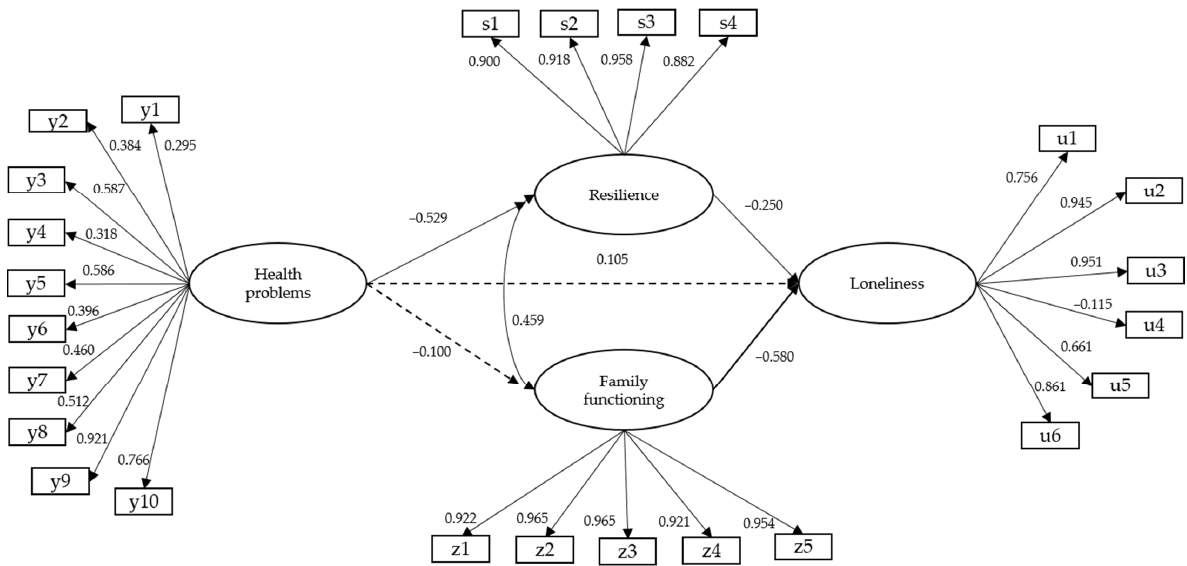
Figure 2. Complete model of structural relationships. Note: dotted line.